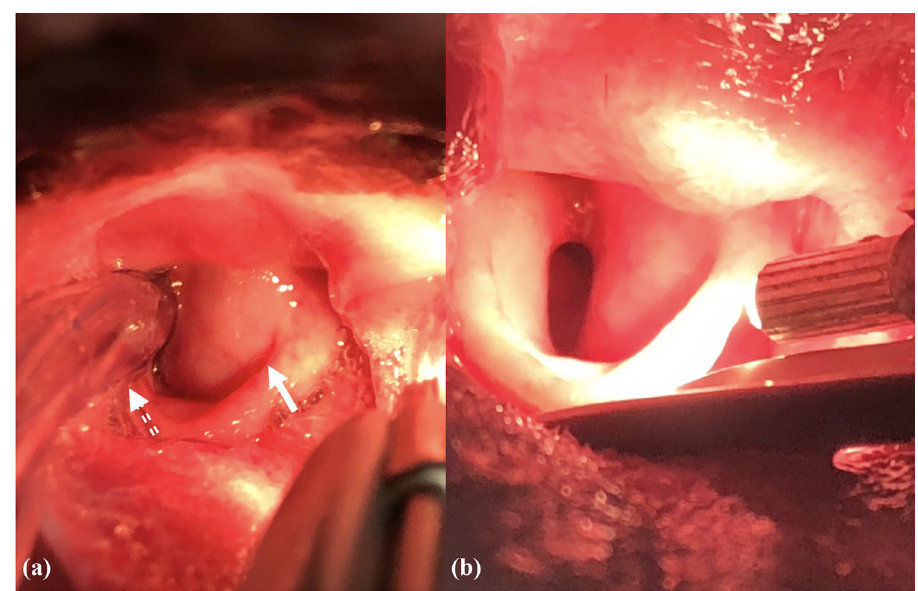
Figure 1: Laryngeal examination ( a ) pre - and ( b ) post - surgery. A thickened left arytenoid cartilage and soft tissue mass ( solid arrow ) arising from the left arytenoid cartilage causing partial airway obstruction. The endotracheal tube ( dashed arrow ) is to the right of the dog. Following surgery, the endotracheal tube was removed, and normal rima glottidis diameter and a patent airway were